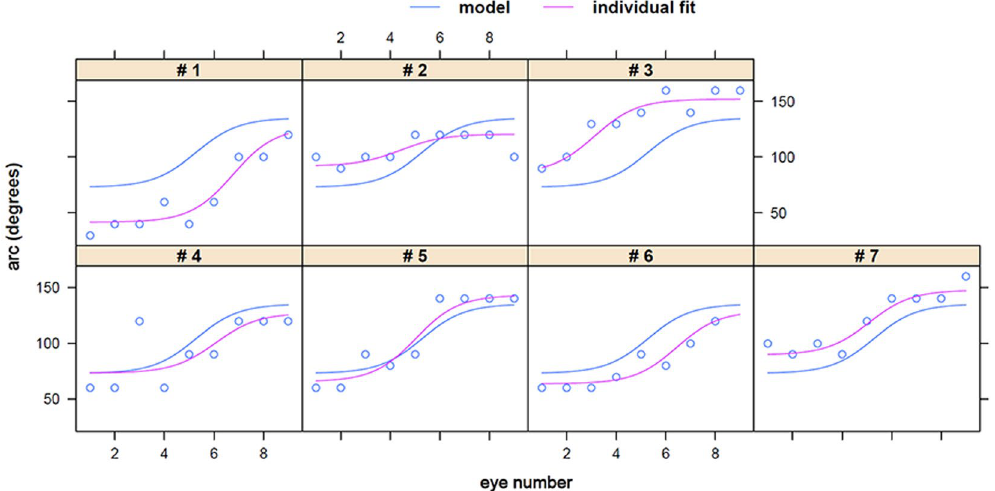
Figure 4. The improvement of ablation arc length could be described as a sigmoidal curve.